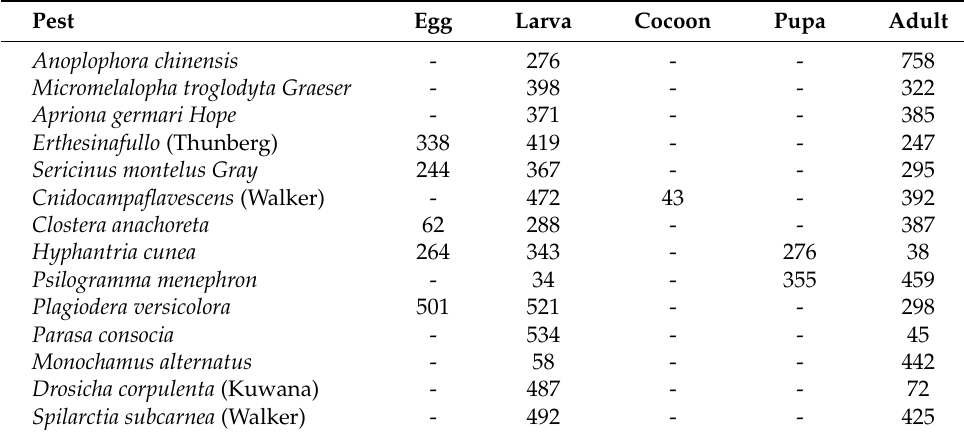
Table 2. Distribution of different species of pest data sets.